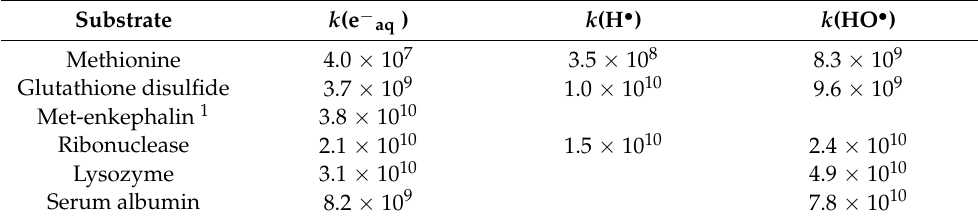
Table 1. Rate constant (M − 1 s − 1 ) of transient species derived from γ -radiolysis of water reacting with peptides/proteins [19].